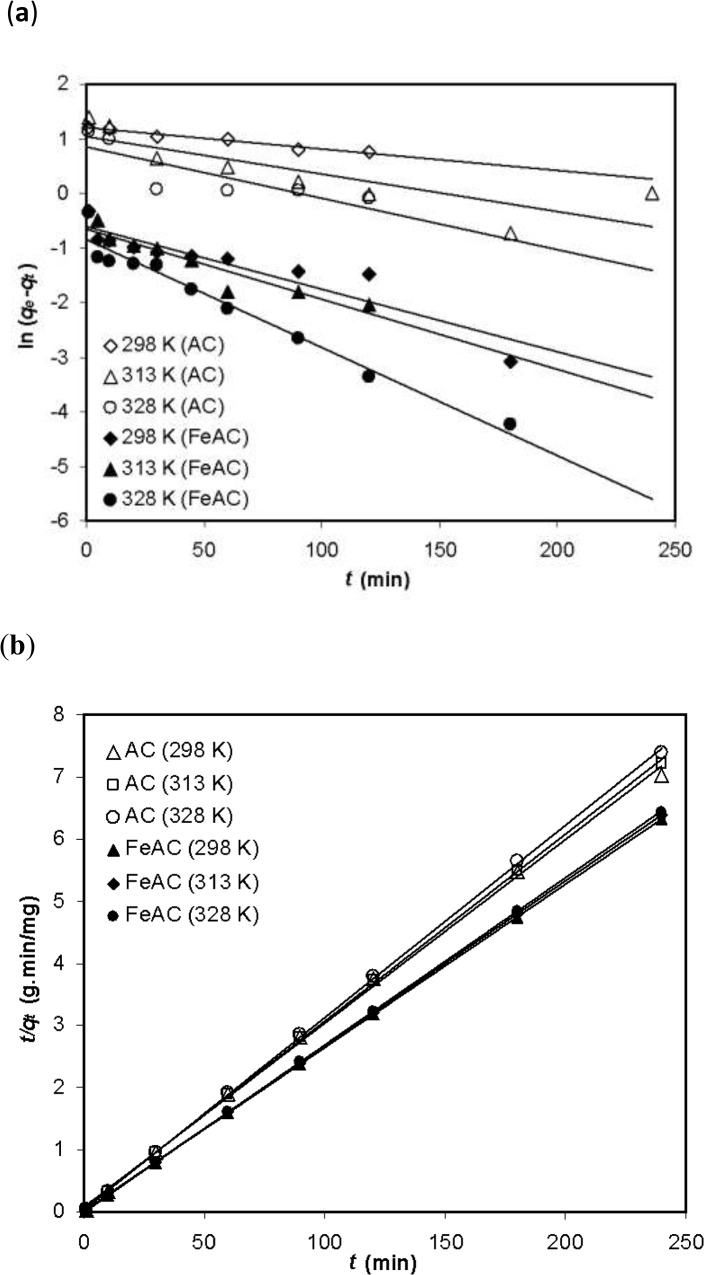
Kinetic investigations on AC and FeAC (a) pseudo–first order (b) pseudo–second order models.